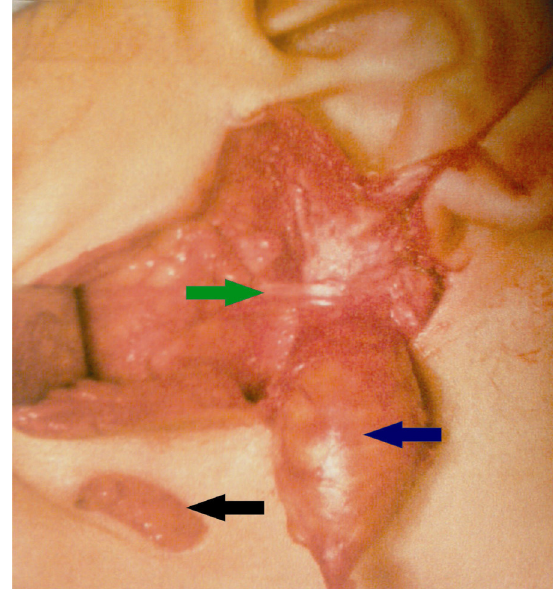
Figure 1 Intraoperative view: the blue arrow indicates the fistulous tract, the green arrow indicates the left facial nerve trunk and the black arrow shows the elliptical excision of the inferior opening of the fistula. inferior cutaneous opening, taking care to preserve the branches of the facial nerve. Finally, the superior opening of the fistula was excised together with a small portion of the cartilaginous floor of the left